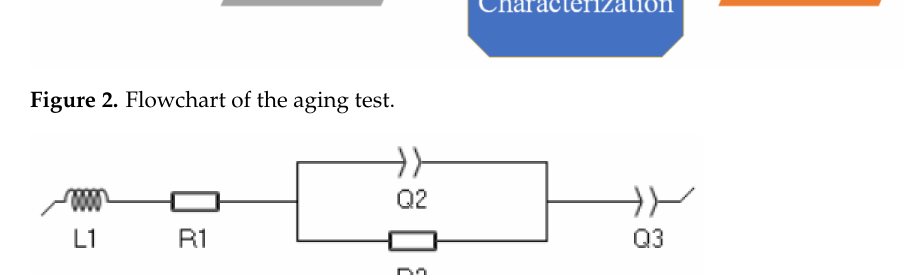
Figure 3. Equivalent electrochemical